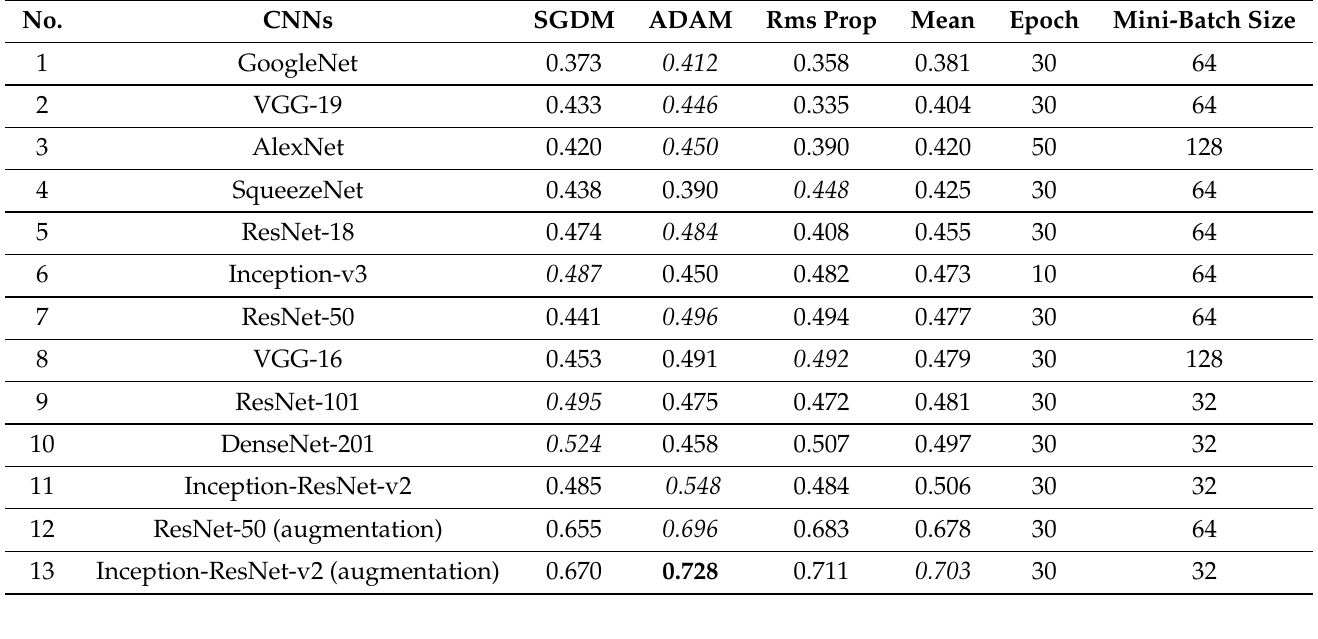
Table 7. Cohen’s kappa results from eleven convolutional neural networks used to classify the wrist images in the MURA dataset. The best results for each row are highlighted in italics and the overall best results are highlighted in bold .